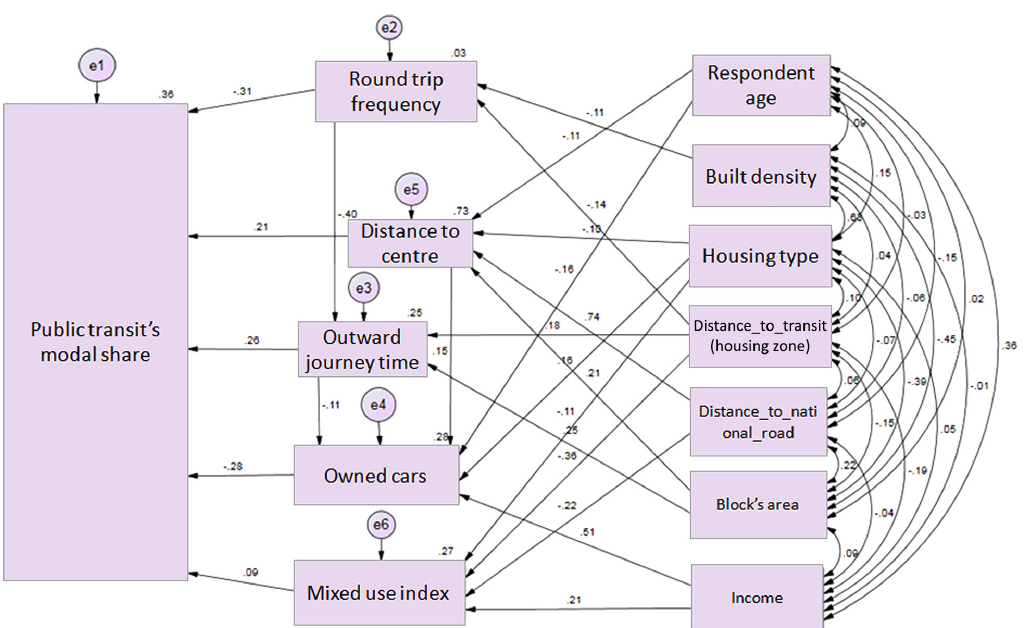
fig. 13. Path analysis of the modal share of public transit.